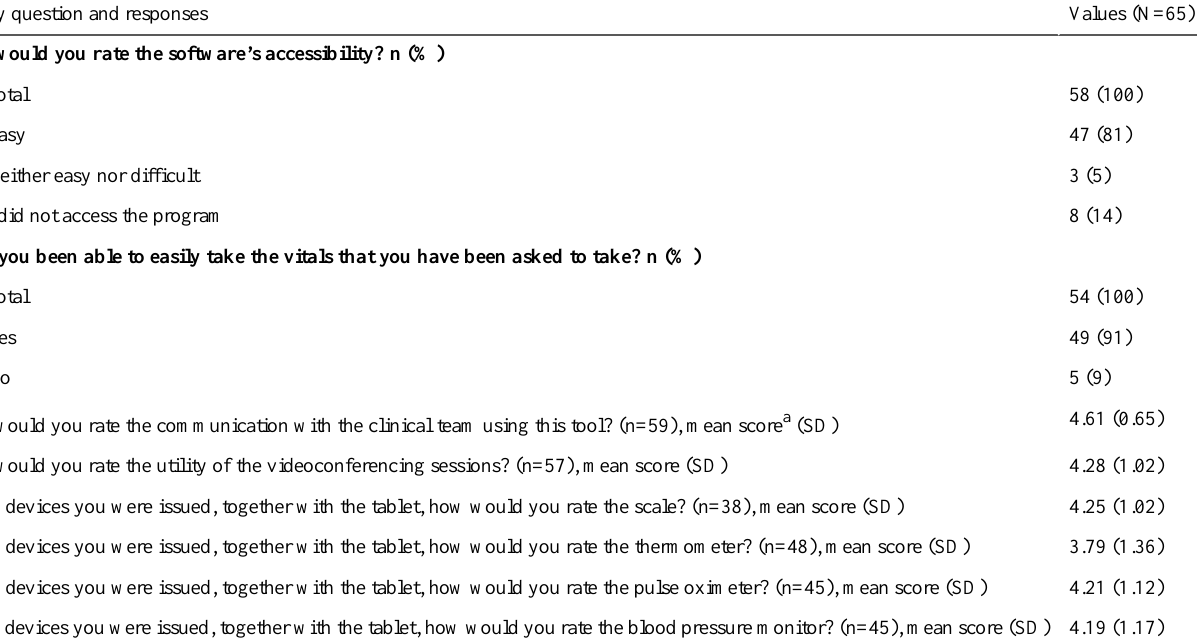
Table 4. Survey results regarding satisfaction with the